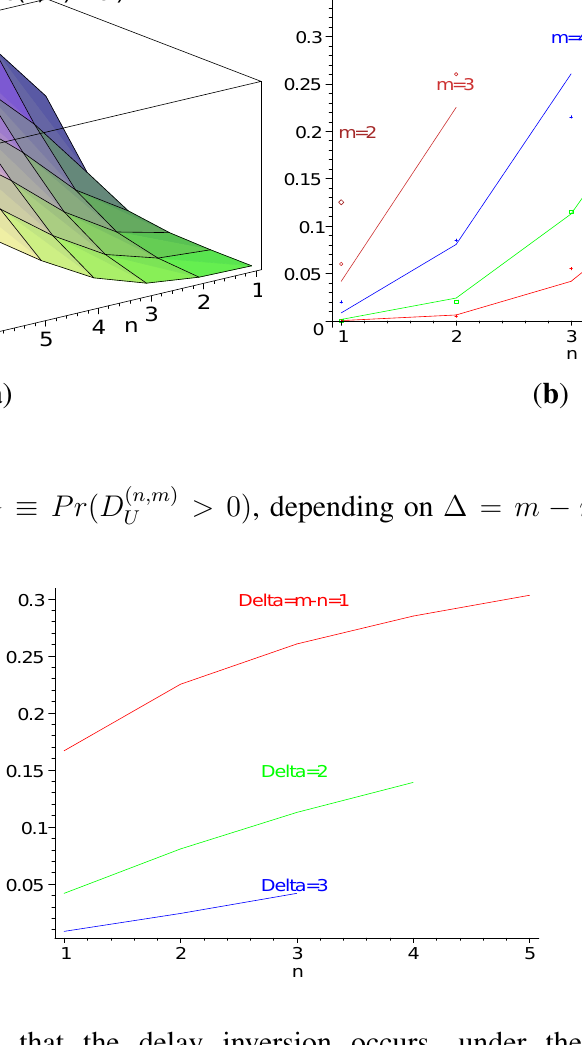
Figure 3. 3D and 2D representation of P for 1 ≤ n ≤ 6 , 1 ≤ m ≤ 6 ; ( b ) Restriction of P values in lines, simulations in points).